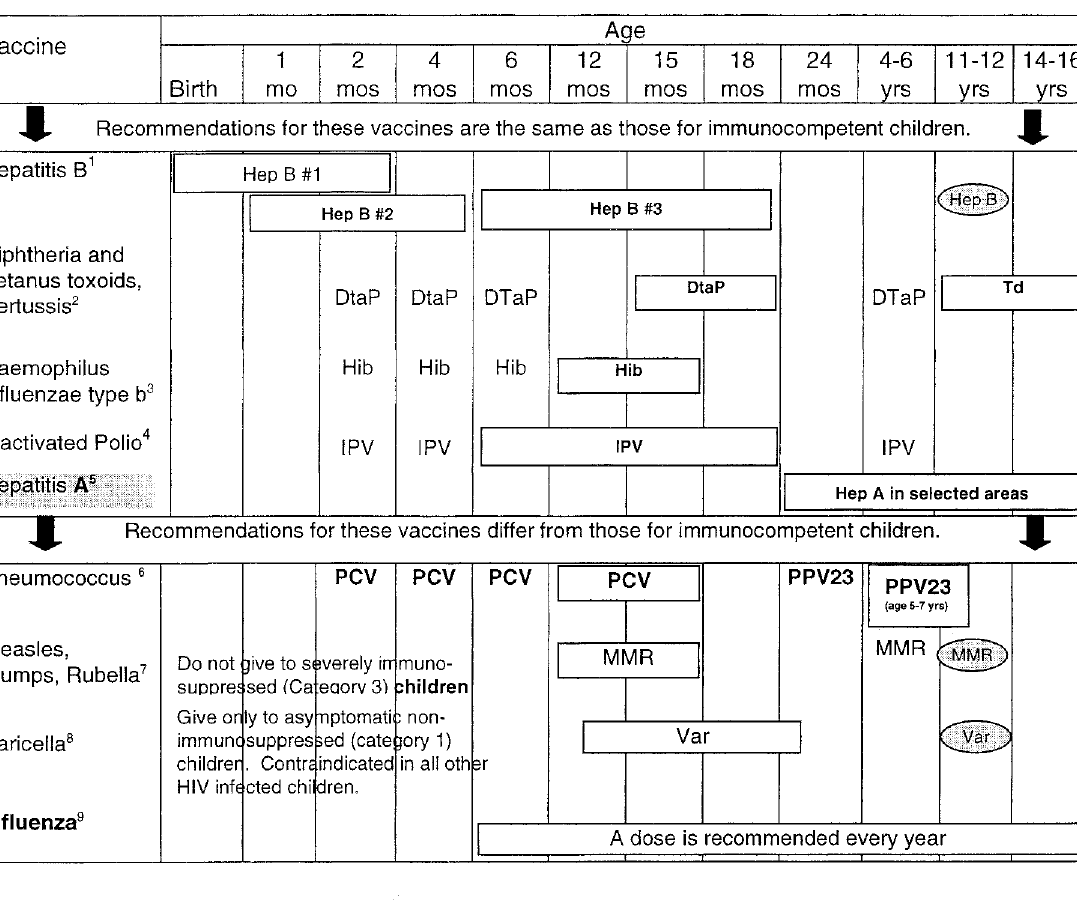
Table 11 Recommended immunization schedule for human immunodeficiency virus-infected